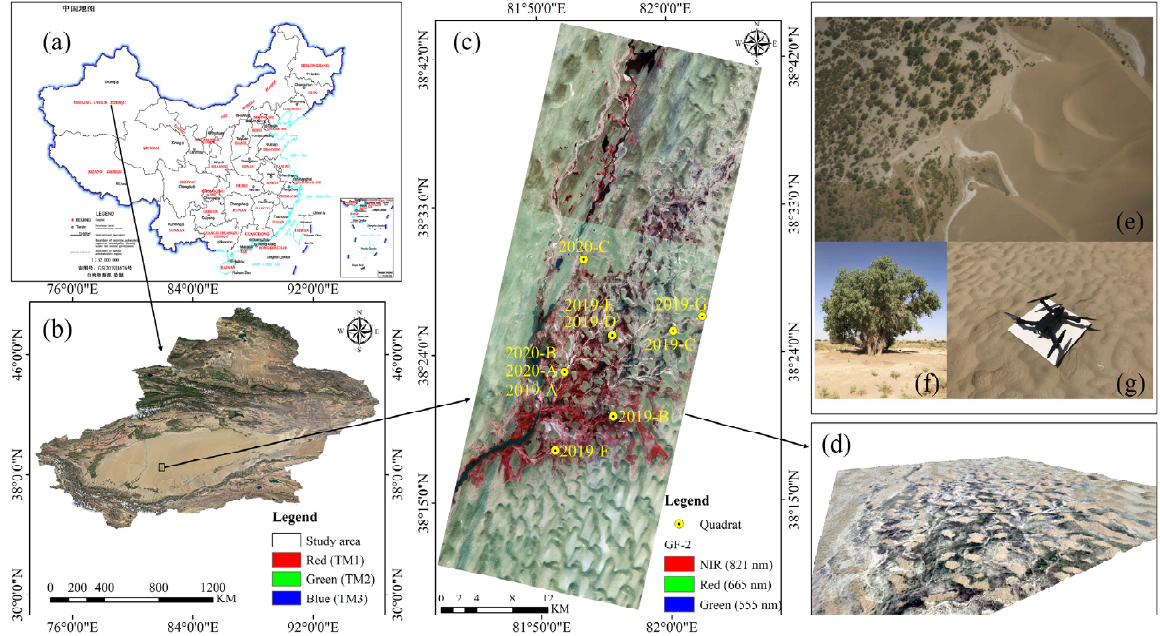
Figure 2. Study area location in Xinjiang, China. ( a ) Map of China, obtained in http://bzdt.ch.mnr.gov.cn/ (accessed on 10 March 2021). ( b ) Satellite map of Xinjiang, downloaded in bigmap software. ( c ) 0.8 m fusion imageries of GF-2 in Daliyabuyi Oasis, September 2018. ( d ) Three-dimensional terrain rendering map of Daliyabuyi Oasis, made in https://elevationapi.com/ (accessed on 10 March 2021). ( e ) RGB photo of UAV in Daliyabuyi Oasis. ( f ) Photo of Populus euphratica in Daliyabuyi Oasis. ( g ) Parrot Sequoia+ UAV system illustration.